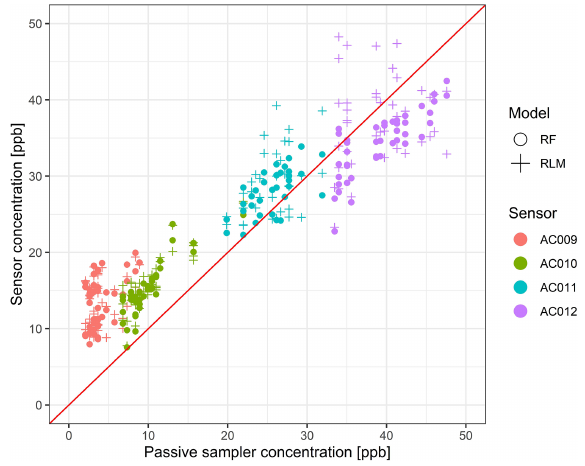
Figure 7. NO 2 sensor performance during the deployment in Zurich illustrated by the sensor concentration comparison to that of NO 2 passive samplers at each